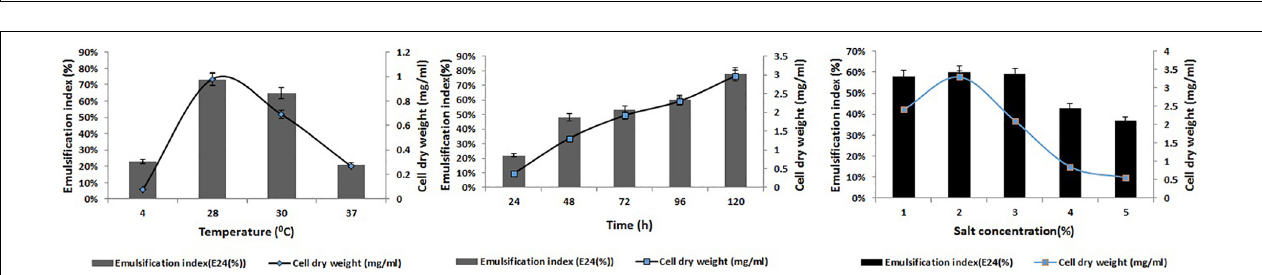
FIGURE 2 | Optimization of various carbon and nitrogen sources and the effect of lactose and peptone on the cell dry weight of MSI 54 and emulsification index.